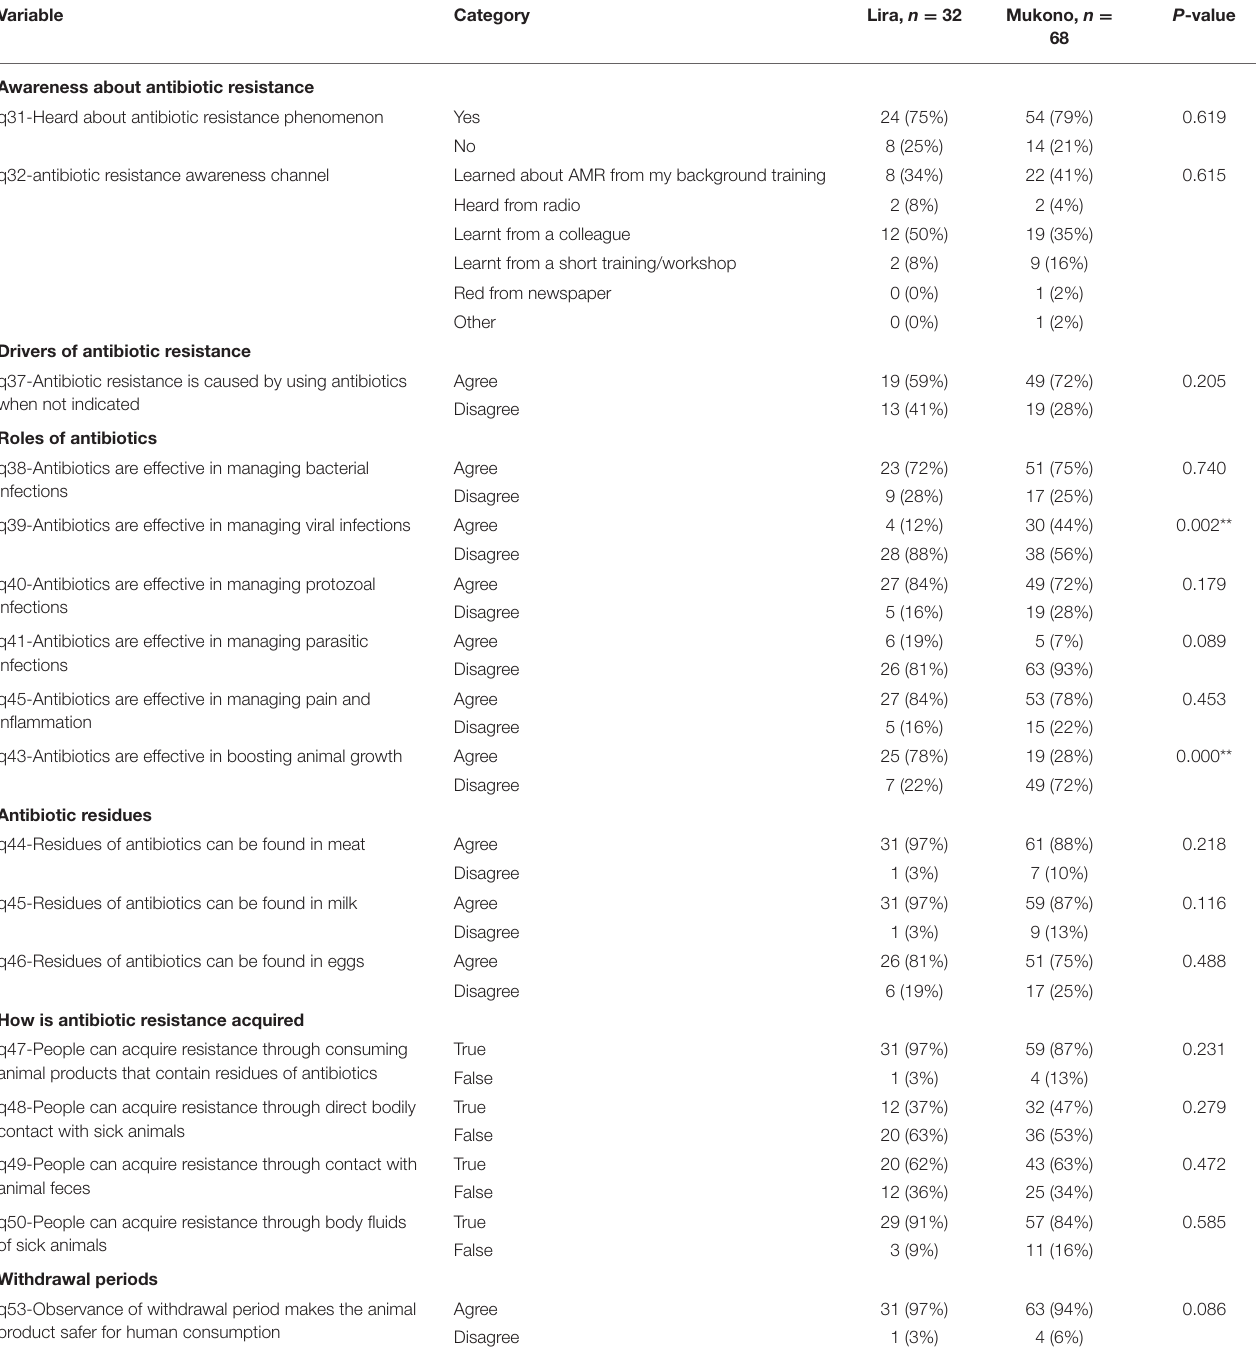
TABLE 7 | Knowledge of veterinary practitioners about roles of antibiotics and antibiotic resistance.